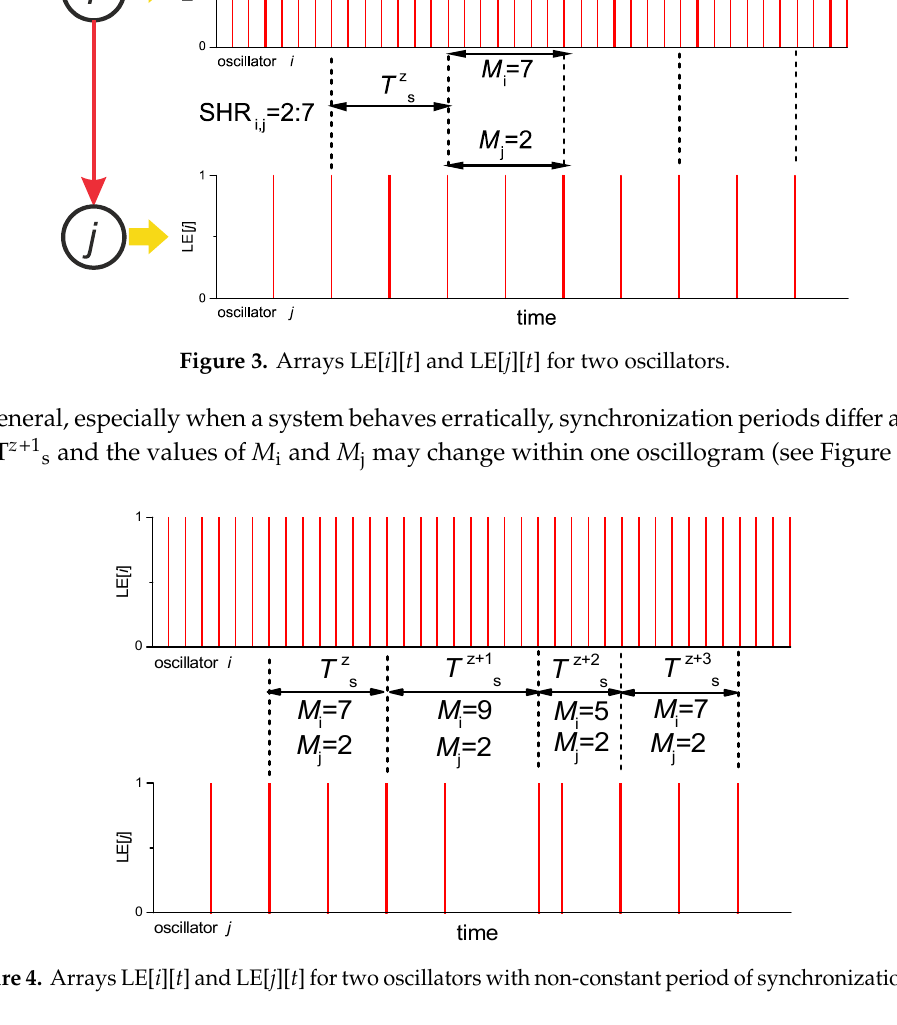
Figure 2. Oscillogram of oscillator current and the corresponding array of positions of the leading edges of the current pulse LE[ i ][ t ]. (where i is the oscillator number, time t = n ⋅ Δ t , n is number of the calculation steps of the model oscillogram, Δ t is the calculation time interval).